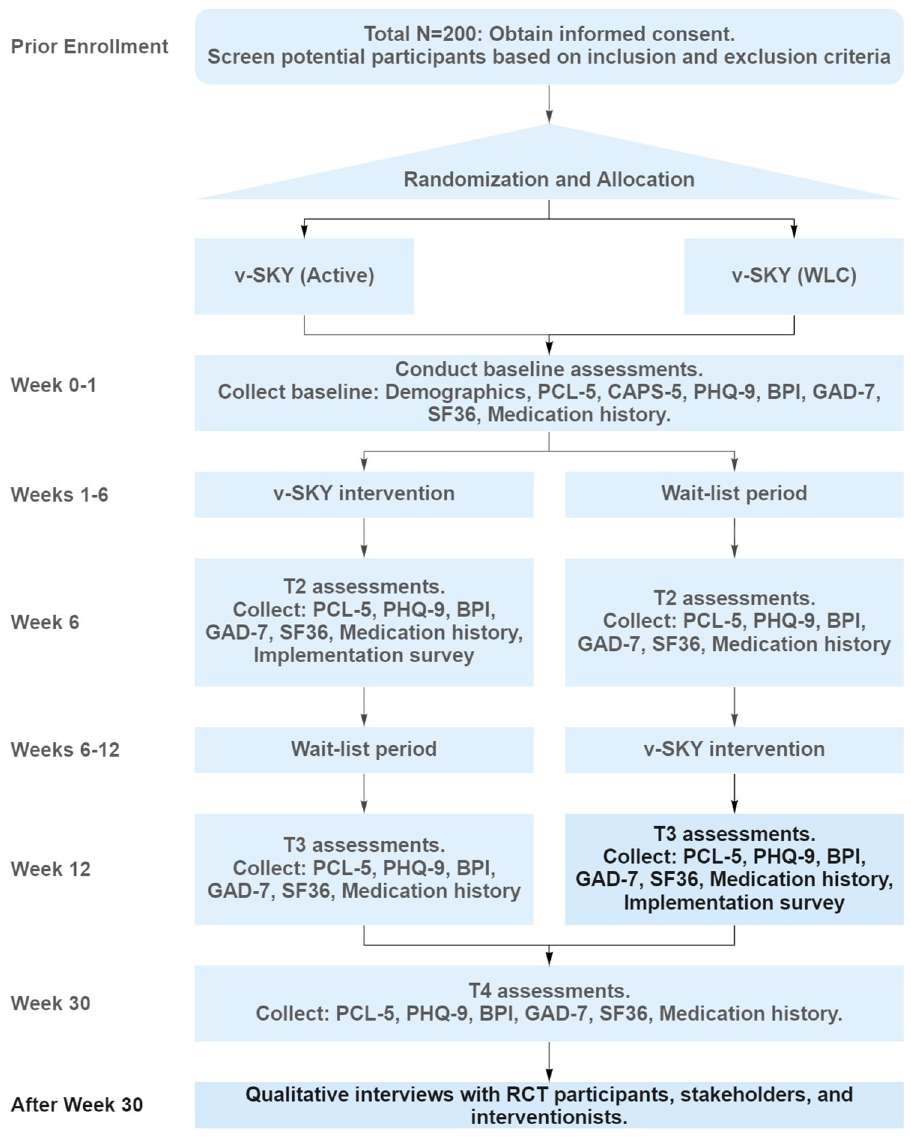
Fig 1. Flowchart showing the timeline of the randomized controlled